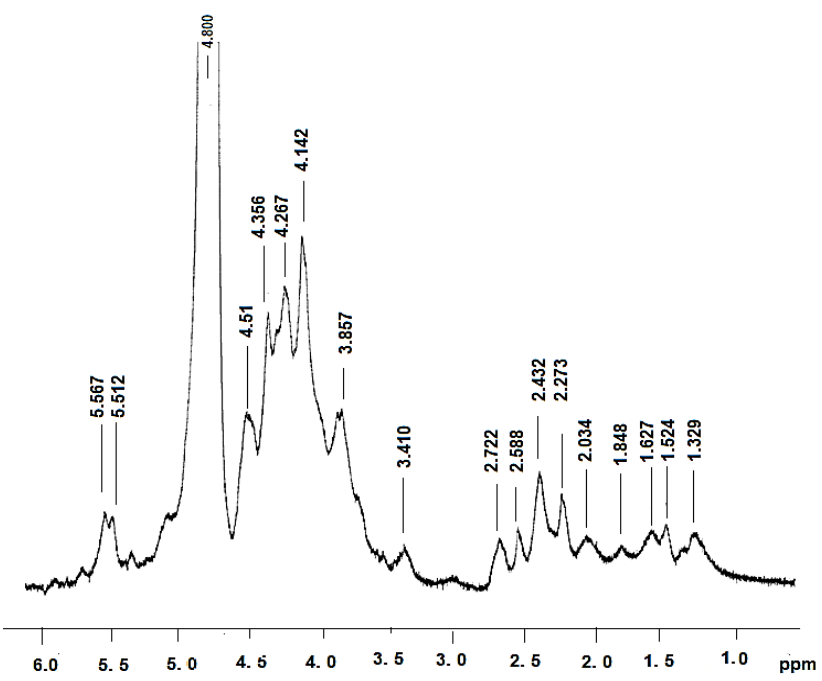
Figure 1. 1 H NMR spectroscopy of Polyporus dermoporus glucan protein